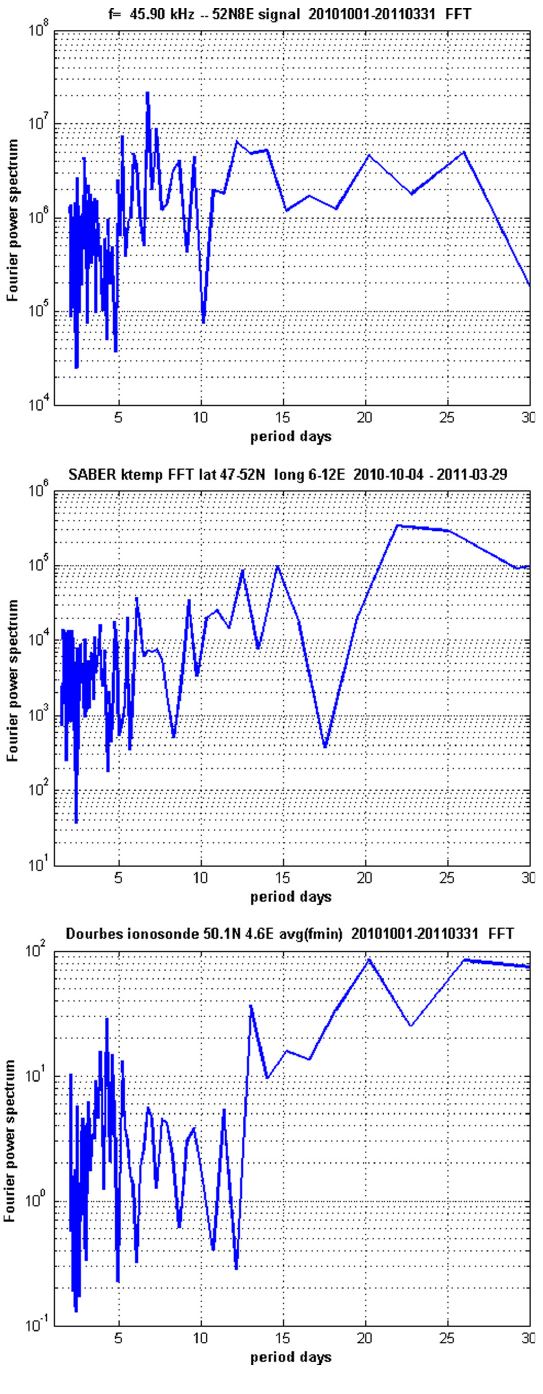
Fig. 5. Fourier power spectra of the data in Fig. 4. Looking at periods longer than 5 days we note: With the VLF data (top) the peaks at 7, 7.5 days period are a consequence of weekly transmitter drop outs (presumably maintenance). Clearly visible are 13-14 days as well as 20 and 26 days periods. With the SABER temperature data (middle) we find periods of 12.5 and 15 days as well as a broad maximum at 22–25 days period. The Dourbes f min absorption data (bottom) show periods of 13, 20 and 26 days (broad maximum).